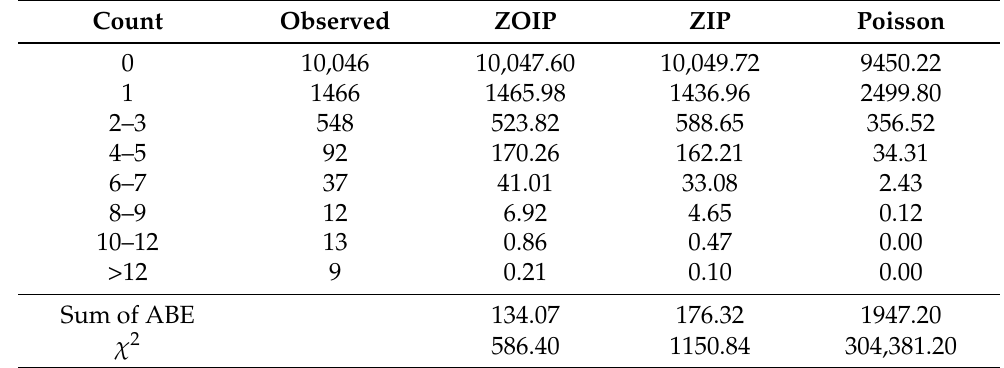
Table 7. Frequency comparisons for ER